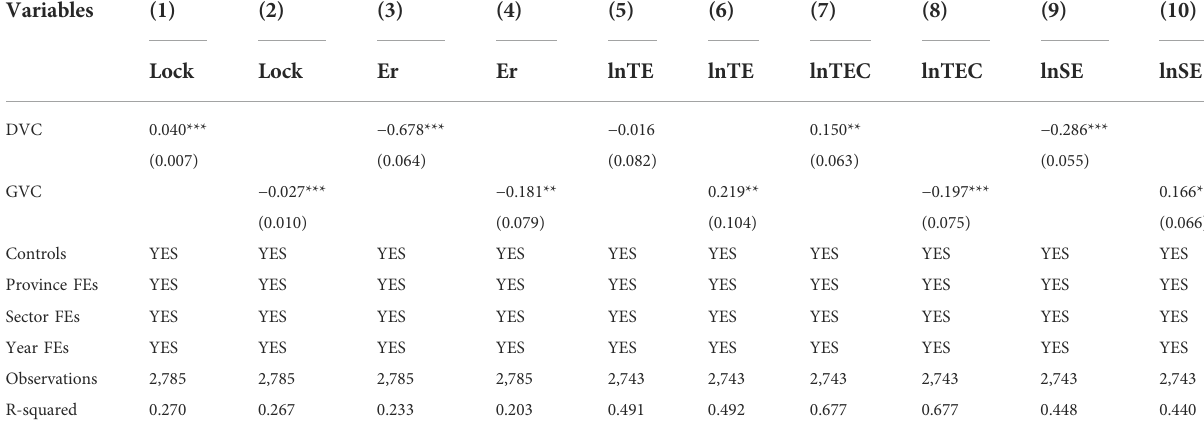
TABLE 8 Results of mechanism